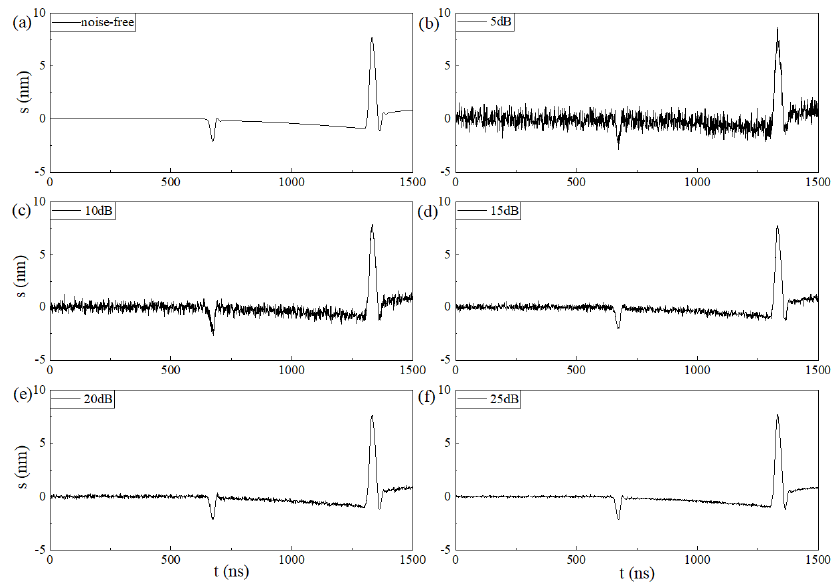
Figure 4. The simulation signal. ( a ) Noise-free signal. ( b ) SNR in = 5 dB. ( c ) SNR in = 10 dB. ( d ) SNR in = 15 dB. ( e ) SNR in = 20 dB. ( f ) SNR in = 25 dB. ( d ) SNR in = 15 dB. ( e ) SNR in = 20 dB. ( f ) SNR in = 25